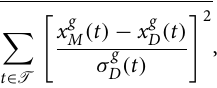
Table 1. Prior distributions for model parameters. Units for (cid:31) 0 , (cid:31) and α are inverse hours ( h − 1 ).